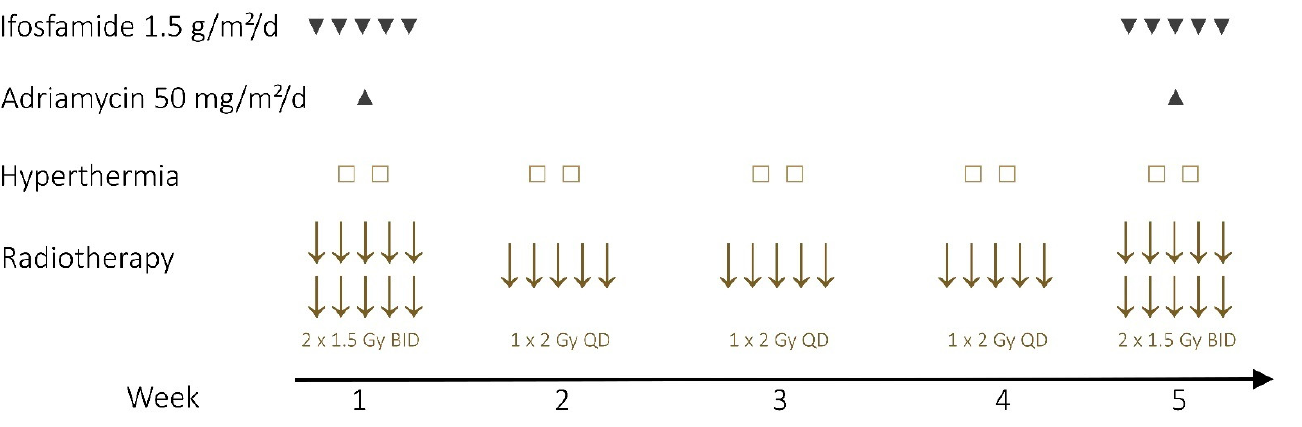
Figure 2. Treatment regimen based on the Erlangen schedule. (BID = twice daily RT, QD = once daily RT).